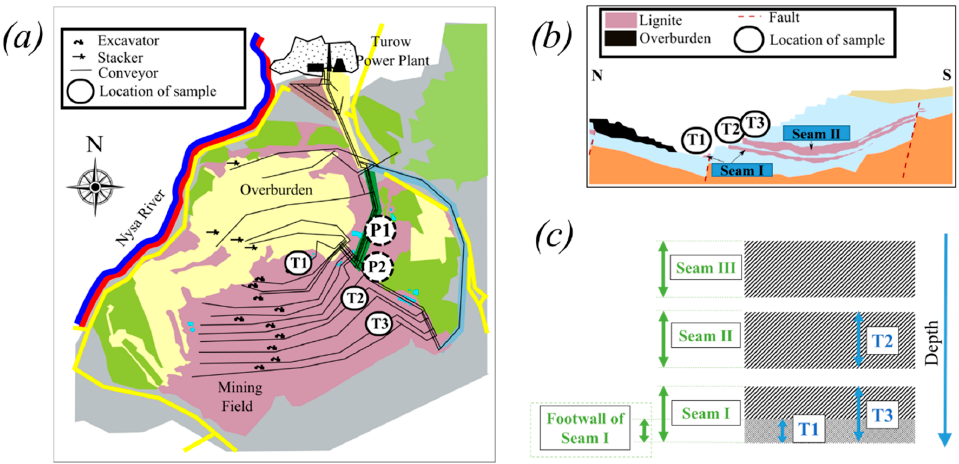
Figure 1. ( a ) Overview of Turow mine; ( b ) profile of the mine; and ( c ) scheme of sample location [20].